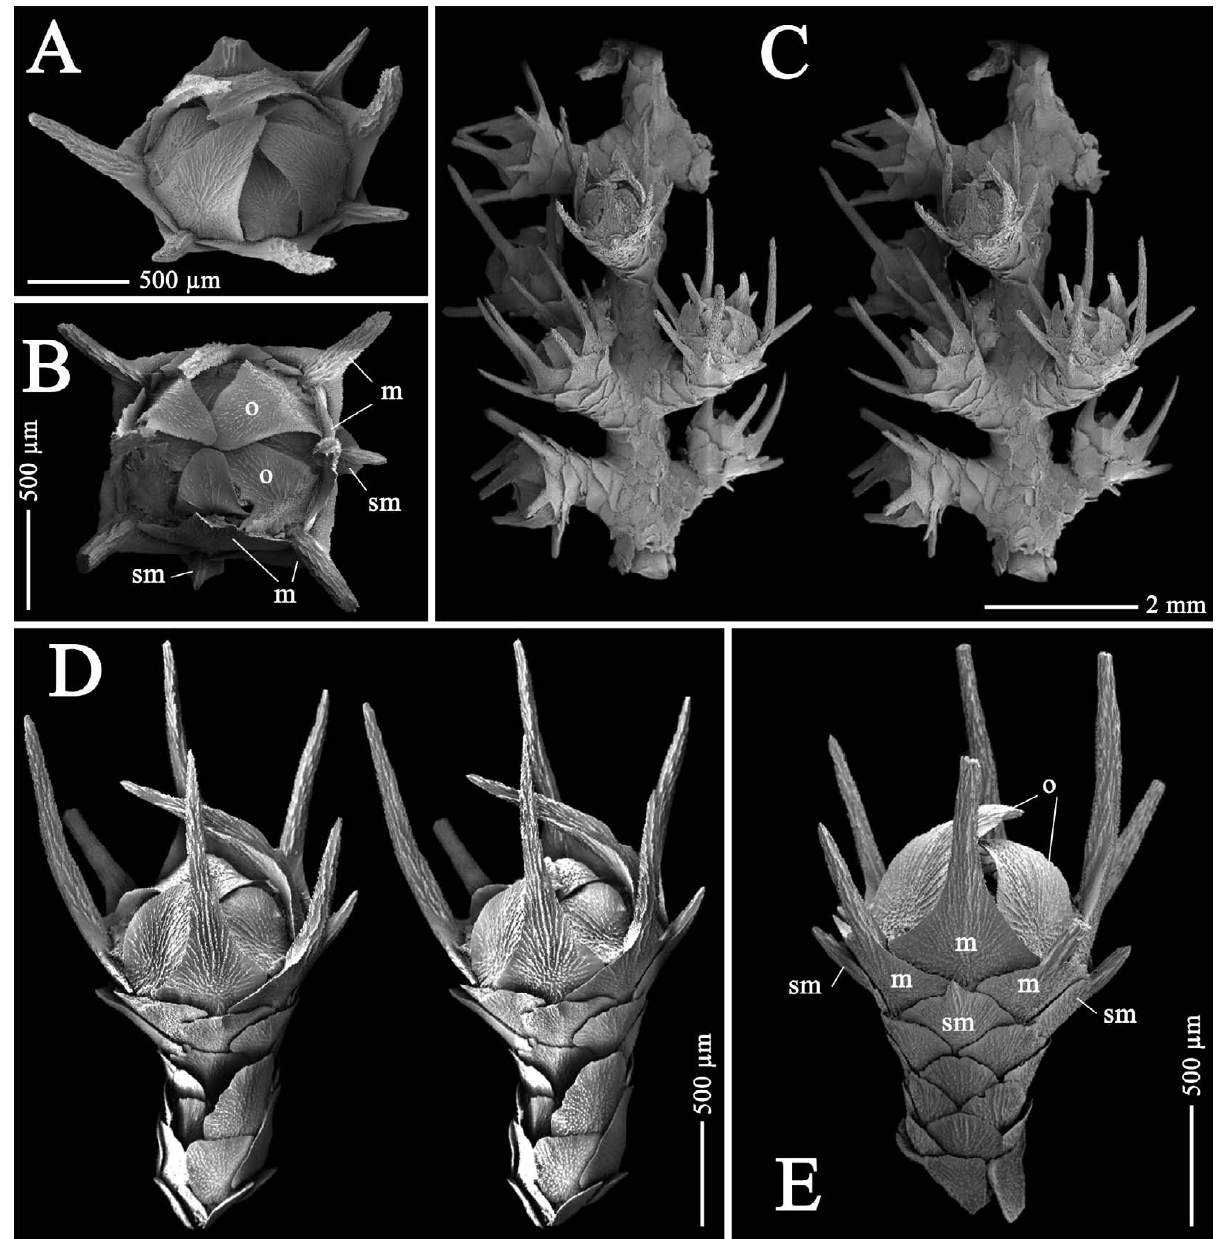
Fig . 3. – Thouarella bayeri n. sp., holotype ZiZMH c11738: a and b, polyps in oral view; c, detail of branchlet, stereo pair; d, polyps on latero-adaxial view, stereo pair; e, polyps in lateral view. abbreviations: o, opercular scales; m, marginal scales; sm, submarginal